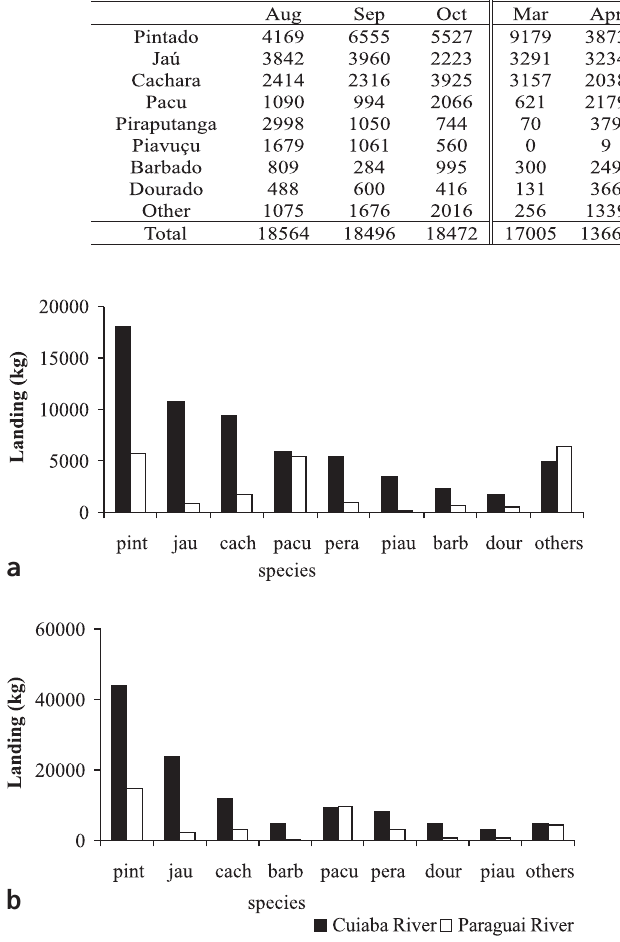
Fig. 2. Landing by species and by river from July to October 2000 (a), and from March to October 2001 (b) at the Cuiabá market (pint = pintado; cach = cachara; barb = barbado; pera = piraputanga; dour =